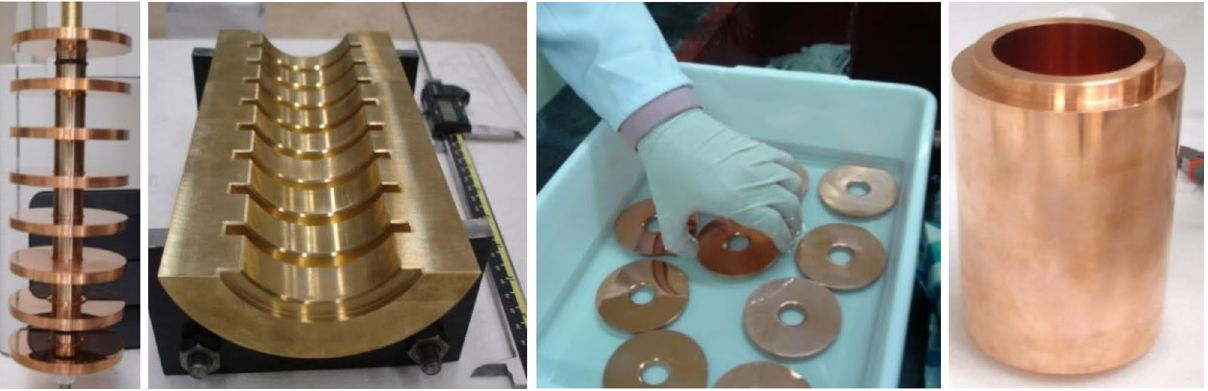
Figure 12. Constructed components of the cavity.